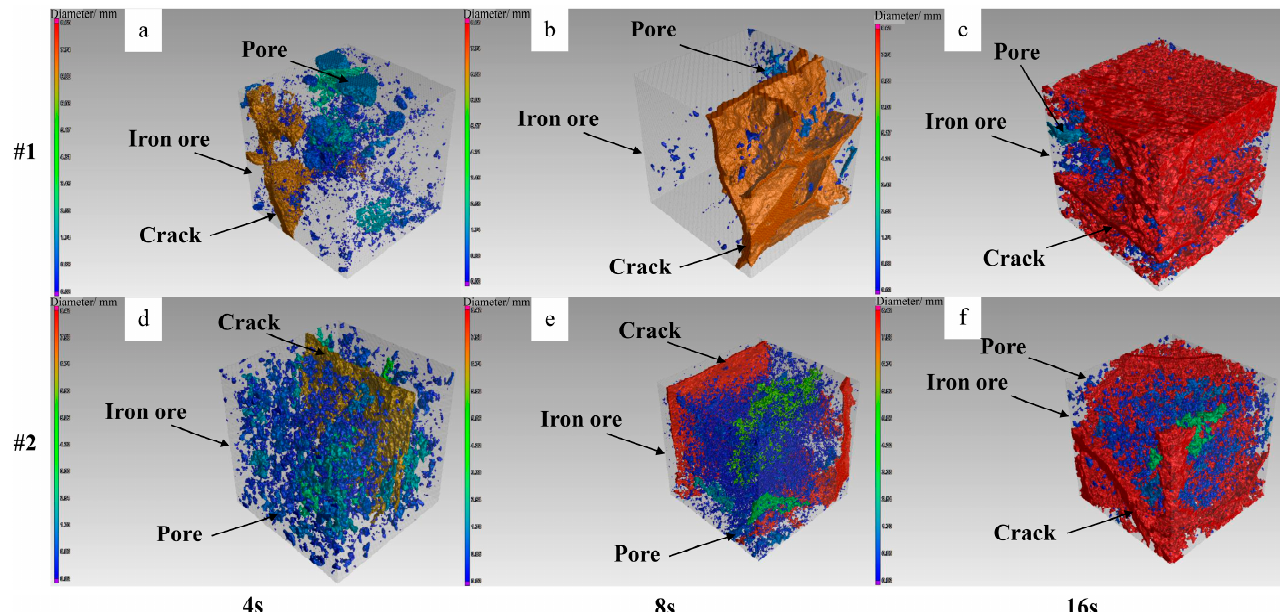
Figure 12. Evolution of the internal pore structure of iron ore at different times of smelting reduc- tion. ( a ) Pore structure of #1 iron ore at 4 s; ( b ) Pore structure of #1 iron ore at 8 s; ( c ) Pore structure of iron #1 ore at 16 s; ( d ) Pore structure of #2 iron ore at 4 s; ( e ) Pore structure of #2 iron ore at 8 s; ( f ) Pore structure of #2 iron ore at 16 s.